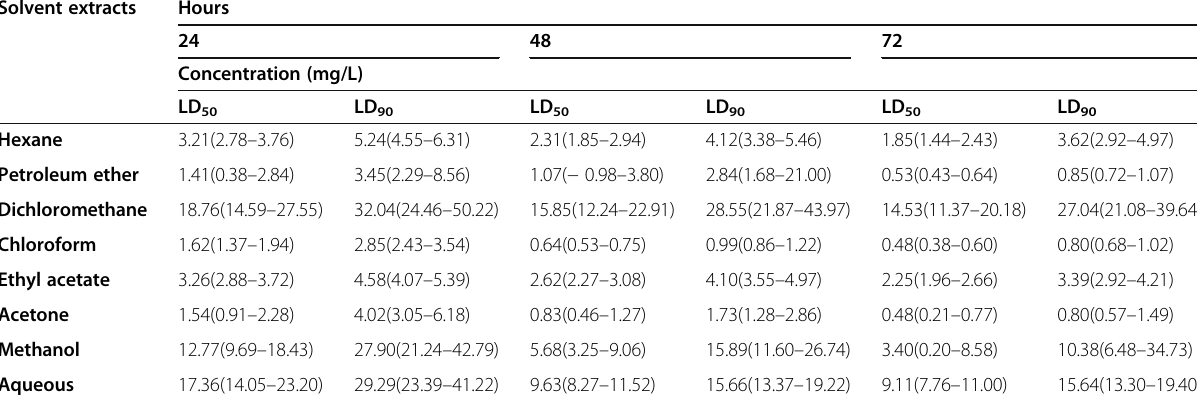
Table 6 Probit analysis of Nicotiana tabacum leaf extracts against the adults of Sitophilus oryzae Solvent